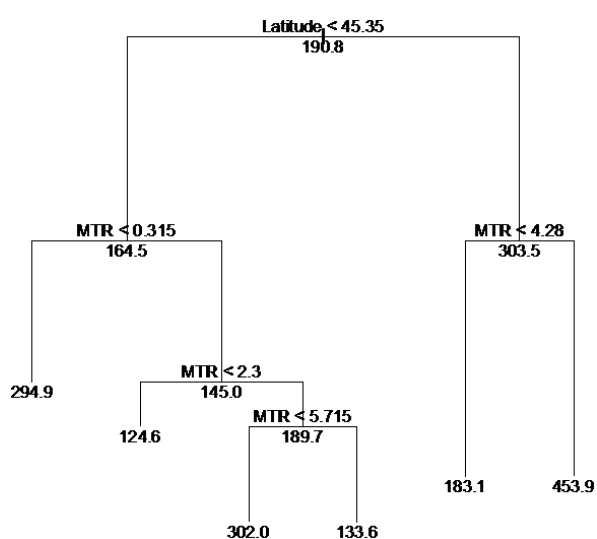
Figure 4. A regression tree for estimating CAR from latitude, mean tidal range and dominated genera. At each internal node, we asked the associated question, and go to the right child if the answer is “no”, go to the left child if the answer is “yes”. MTR denotes mean tidal